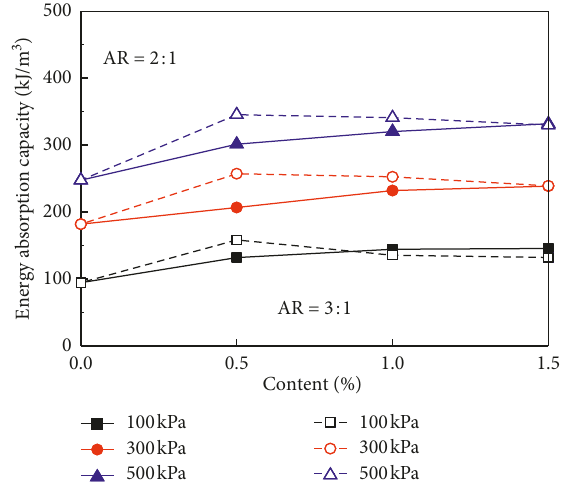
Figure 7: Variations in energy absorption capacity under the ef- fects of fabric block content and aspect